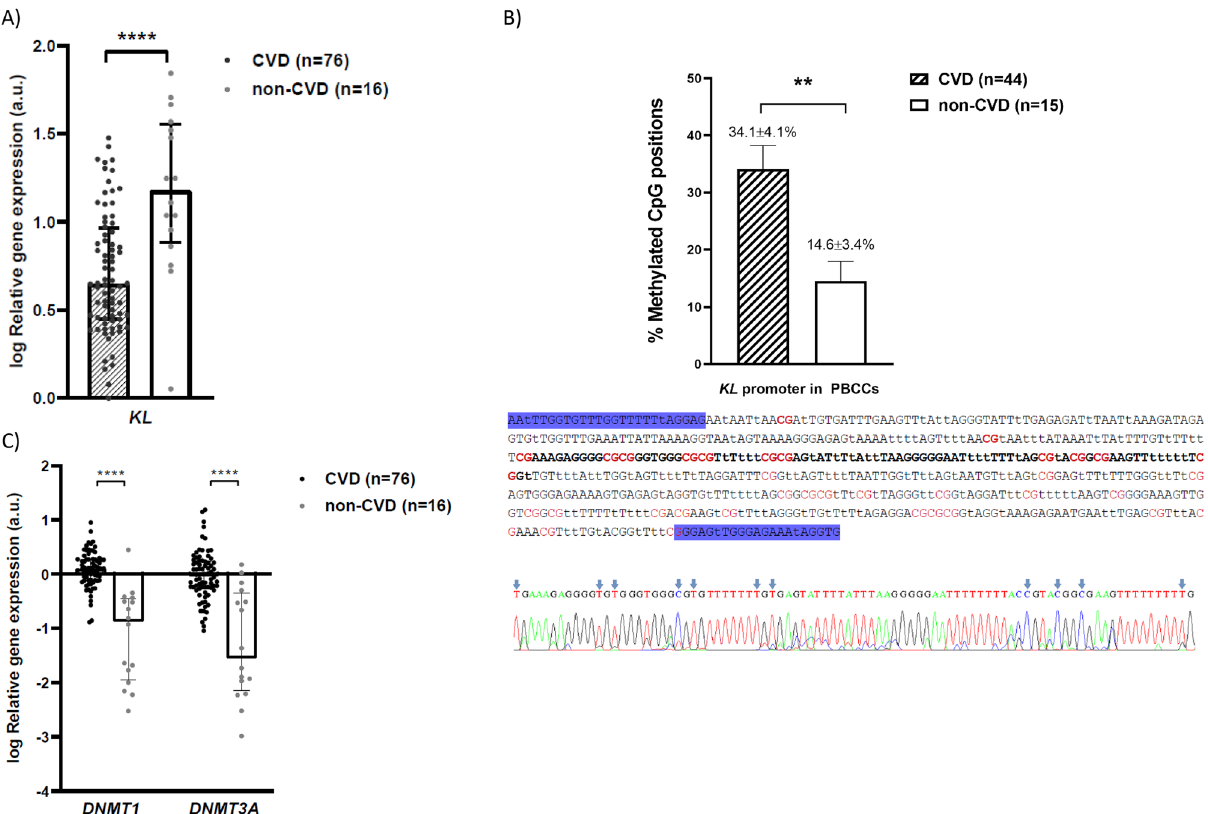
Figure 3. KL gene expression and epigenetic regulation in PBCCs of CVD and non-CVD subjects. ( A ) Relative gene expression levels of KL locus , ( B ) methylation levels of 11 CpG positions (red) in the − 648 and − 560 regions (bold) of KL gene promoter (lowercase “t” represents unmethylated cytosines after conversion with sodium bisulfite), ( C ) relative gene expression levels of DNMT1 and DNMT3A loci . a.u.: arbitrary units. Bars and range represent median and IQR ( A and C ) or mean and SEM ( B ). **: P < 0.01; ****: P <